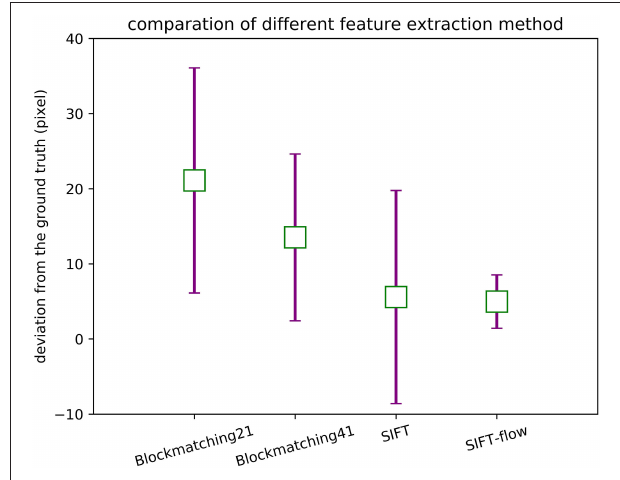
FIGURE 6 | The mean and the variance in the distances between the extracted correspondences and the ground